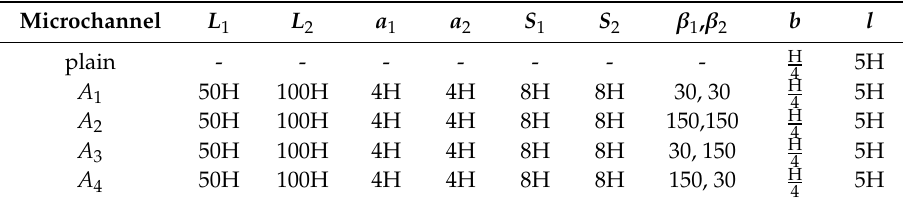
Table 1. List of various microchannel configurations .